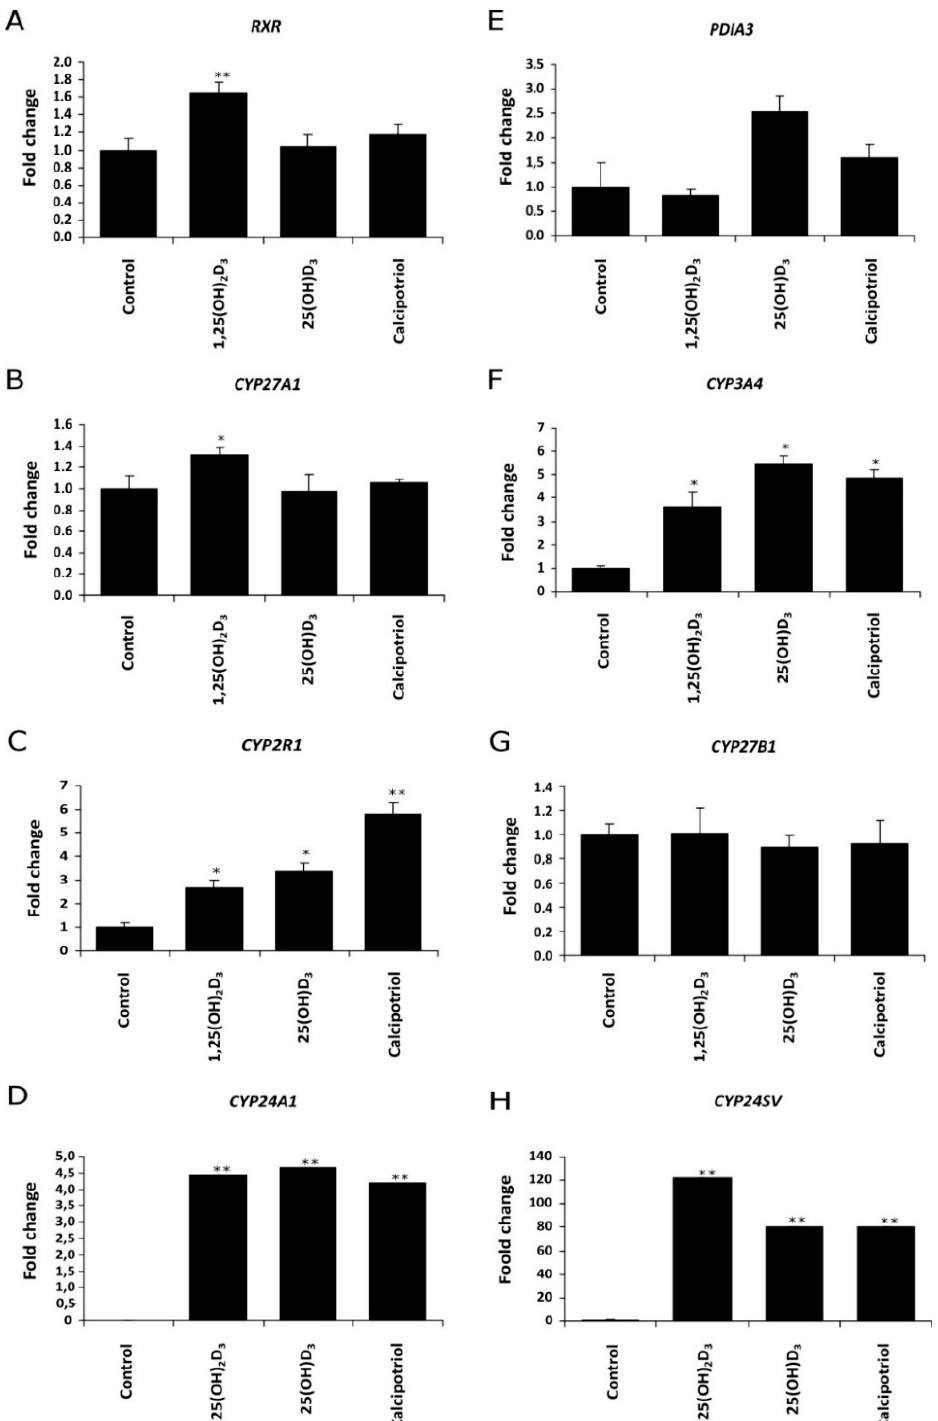
Figure 4. Vitamin D analogs treatment modulate the expression of ( A ) retinoid X receptor ( RXR ), ( E ) disulfide isomerase ( PDIA3 ), 25-hydoxylases (( B ) CYP27A1 , ( C ) CYP2R1 or ( F ) CYP3A4 , ( G ) 1 α -hydroxylase ( CYP27B1 )) and 24-hydroxylases (( D ) CYP24A1 or ( H ) CYP24SV ) in WM98 melanoma cell line. Cells were stimulated with 1 µ M 1,25(OH) 2 D 3 , 25(OH)D 3 or calcipotriol for 24 h. Quantitative PCR analyses were performed as described in Materials and Methods. Statistical significance was estimated using t -test and data are presented as means ± SD ( n = 3). The cutoff point for significance is defined as p < 0.05 (* p < 0.05, ** p < 0.01).